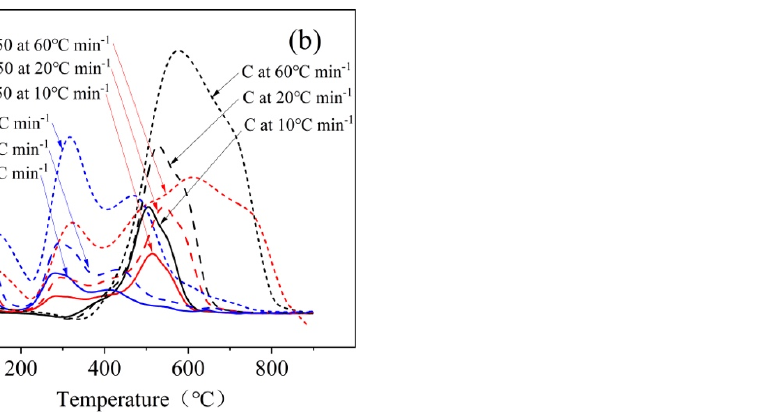
Table 2. Kinetic properties of coal, municipal sludge and their blends at heating rates of 10 ( a ), 20 ( b ) and 60 ( c ) °C/min.